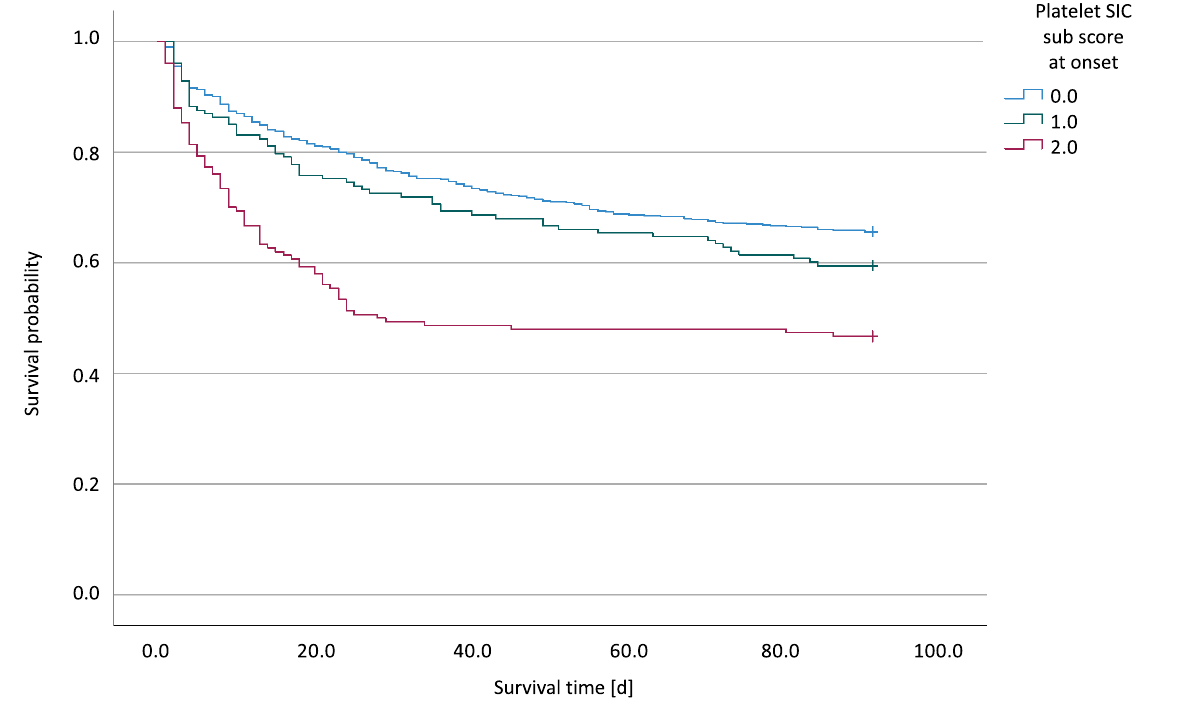
Fig. 4 Kaplan–Meier plots of patients included in the SISPCT trial, stratified for the platelet-sepsis-induced coagulopathy subscore (PSSC) at sepsis onset. N 675 patients having a PSSC of 0 (blue line), n = line); p <